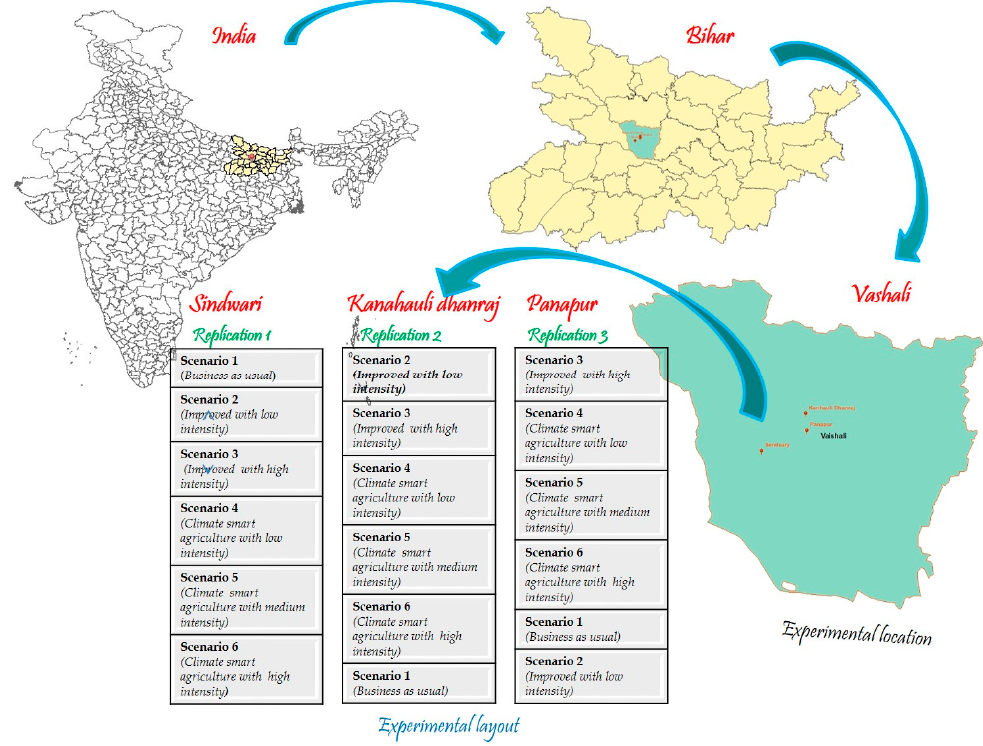
Figure 1. Location and layout of experimentation; Sindwari (25°44 ′ N 085°16 ′ E), Kanahauli dhanraj (25°47 ′ N 085°21 ′ E and Panapur (25°46 ′ N 085°21 ′ E) in Vashali district of Bihar, India.